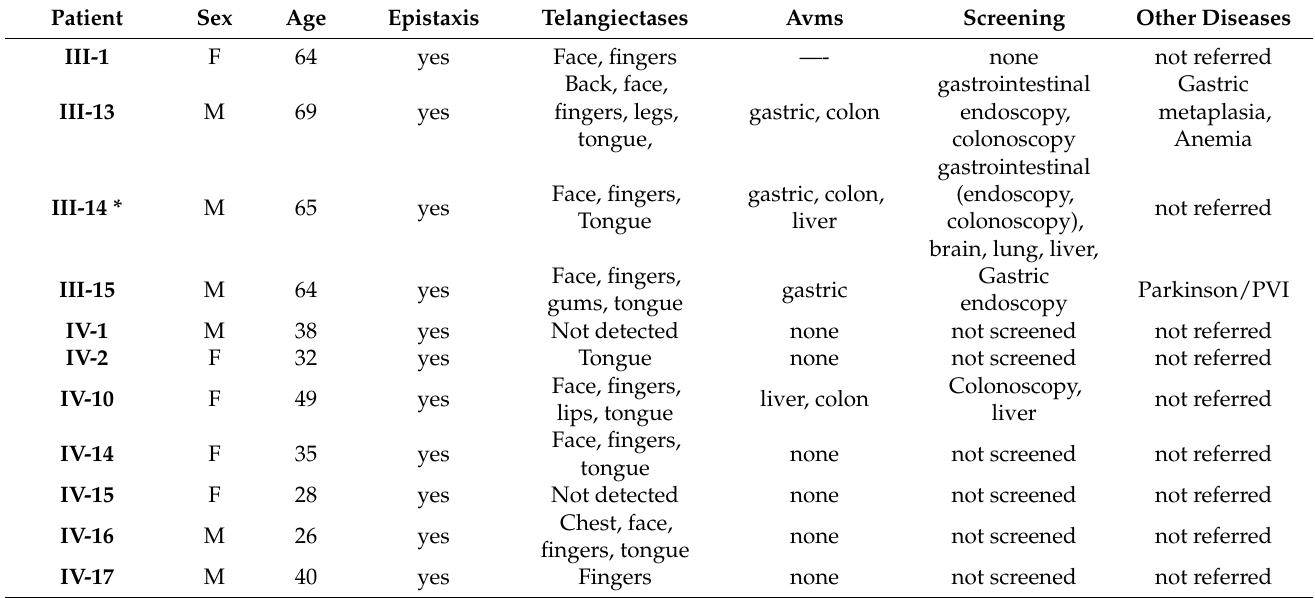
Table 2. Clinical symptoms of the family members with Curaçao criteria (* indicates index case, F: female, M: